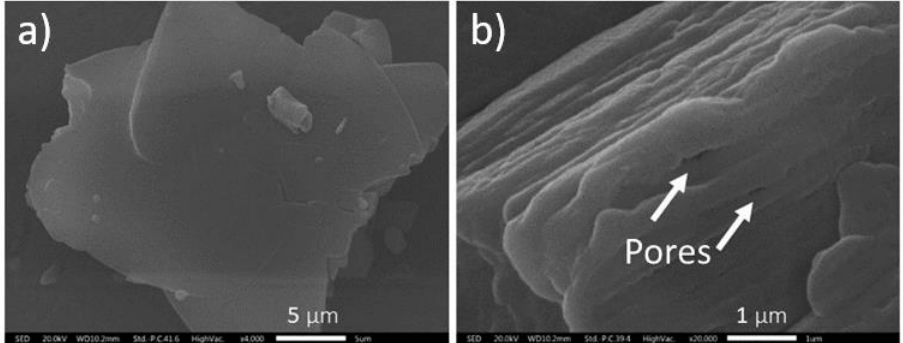
Figure 2. SEM micrographs of gCN powder: ( a ) image of the typical gCN particle; ( b ) details of the pores observed on the gCN surface.